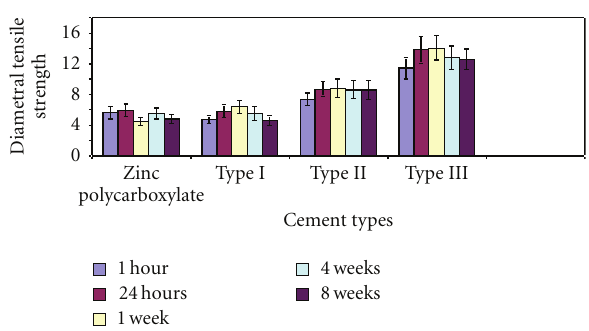
Figure 2: Histogram showing the mean diametral strength of zinc polycarboxylate cement and the three polymeric CPCs in MPa.